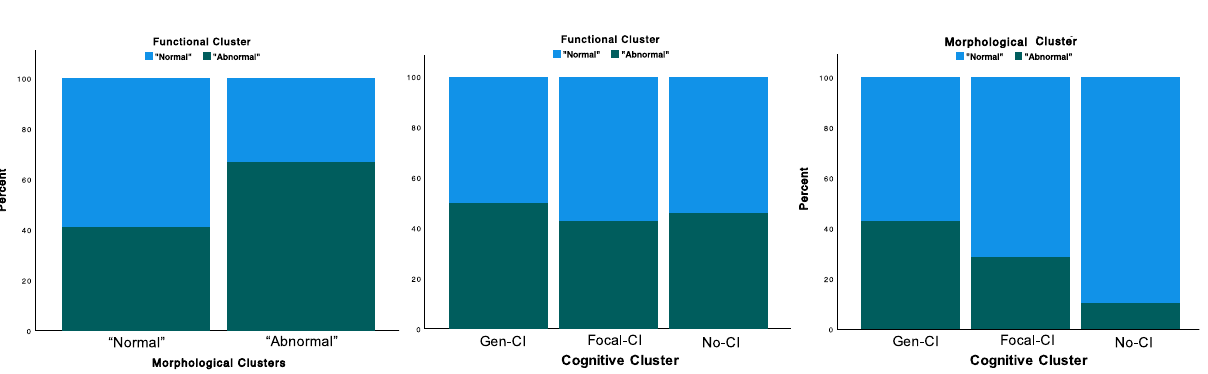
Figure 4. (Left) Proportion of TLE participants in morphological clusters vs functional clusters, (middle) proportion of TLE participants in cognitive clusters vs functional clusters, and (right) proportion of TLE participants in cognitive clusters vs morphological clusters. Results were significant for the left and the right